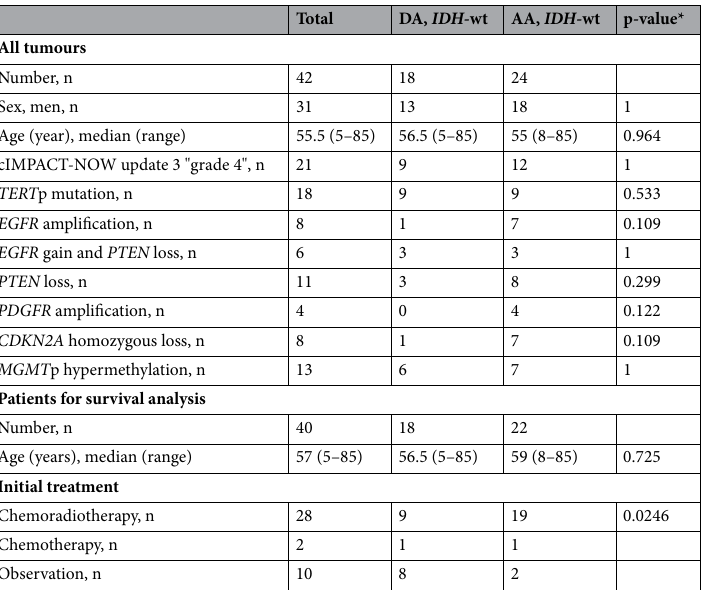
Table 1. Characteristics of all patients included in the present study. AA anaplastic astrocytoma; DA diffuse astrocytoma; IDH -wt, IDH wild type. *The p-values for comparisons between DA and AA groups are calculated with Student’s t-test for age and with Fisher’s exact test for the